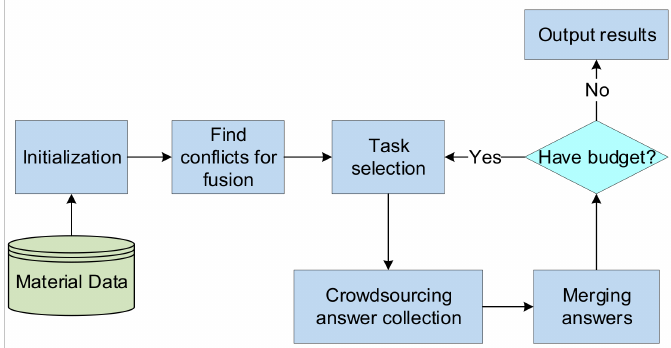
Figure 4. The working process of a crowdsourcing fusion